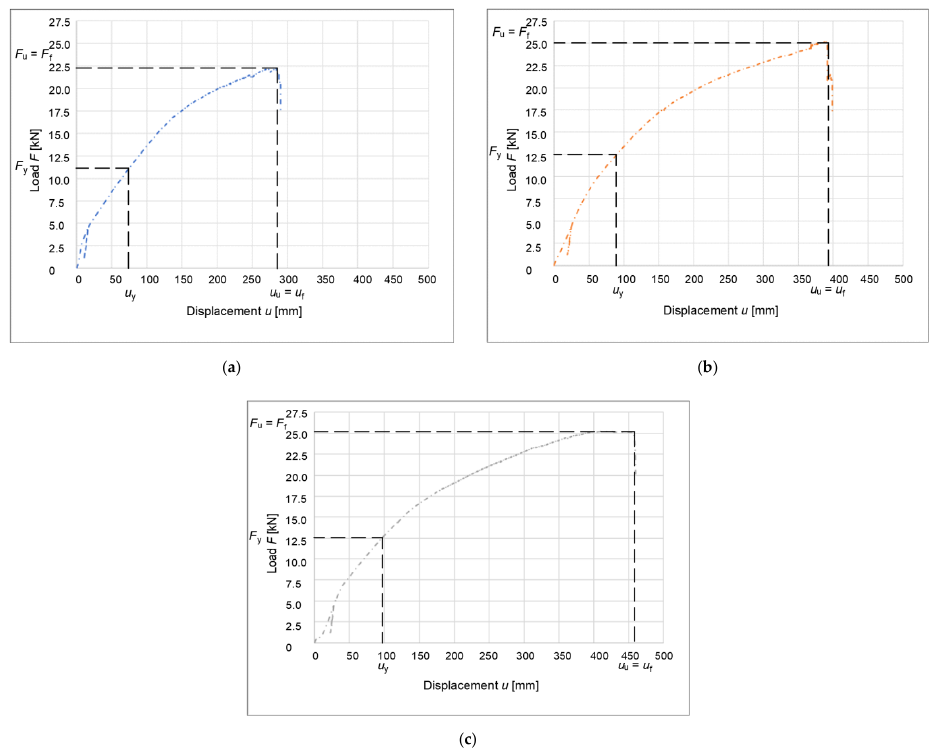
Figure 21. Graphical representation of the yield strength of a connection formed from bolts and dowels according to Karacabeily and Ceccotti (1998): ( a ) unreinforced specimen; ( b ) reinforced partitions; and ( c ) reinforced rung and struts (stands).